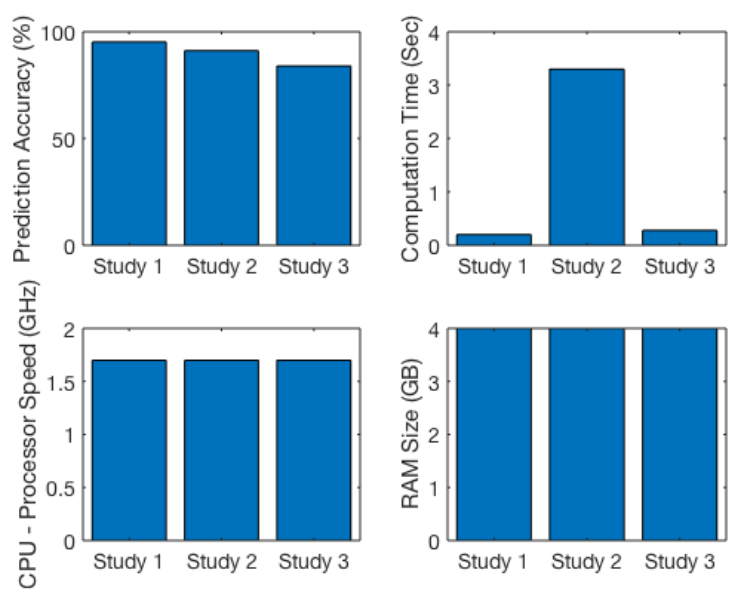
Figure 7. Influence of computer processor speed (CPU) and memory capacity (random-access memory (RAM) size) on prediction accuracy and computation time for Study 1, Study 2, and Study 3 (this study) shown in Table